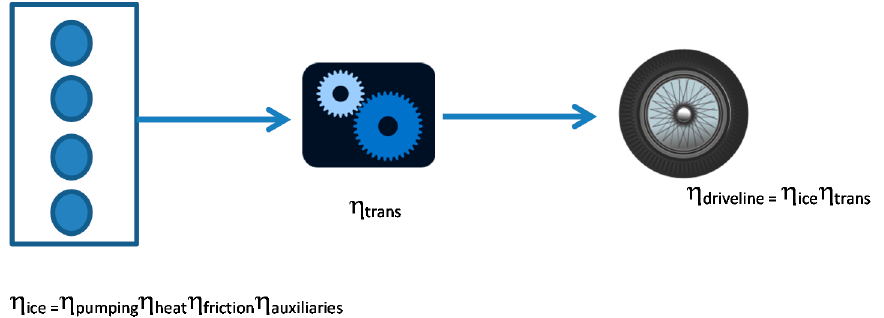
Figure 2. Conventional compression ignition / spark ignition powertrain.